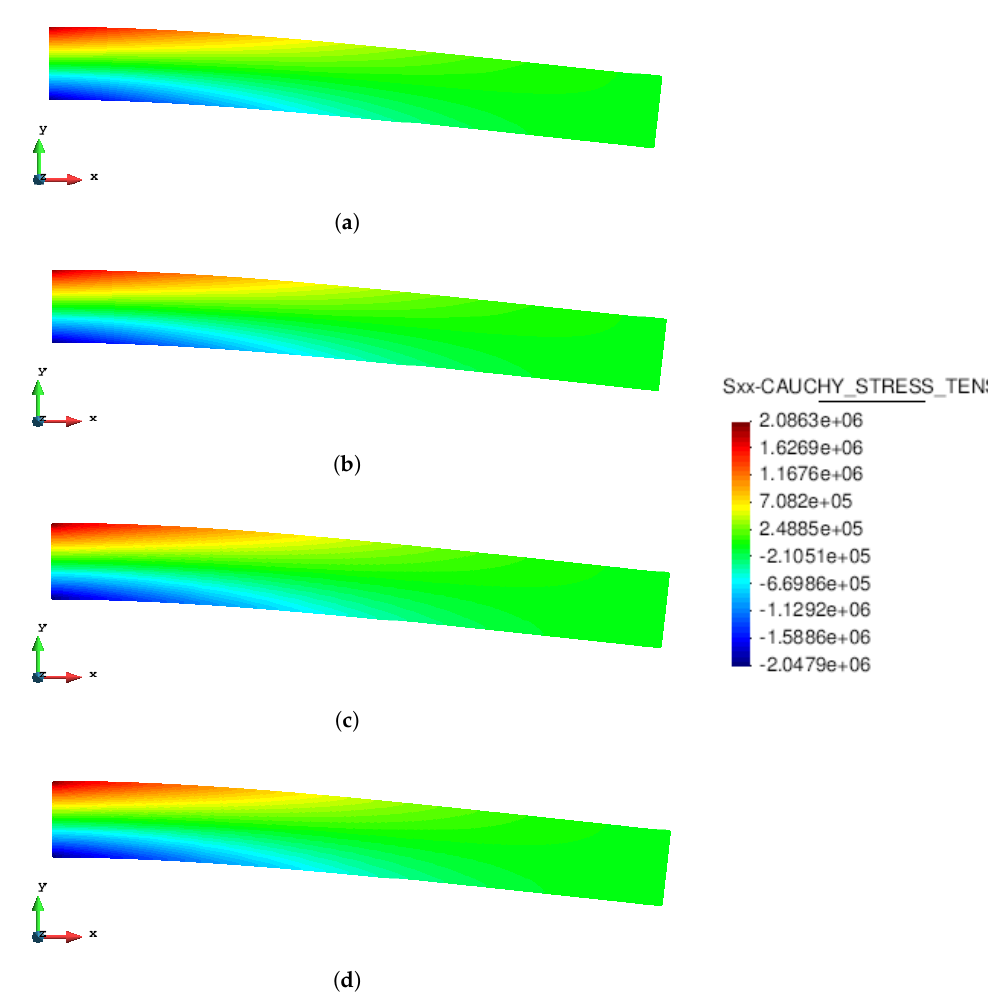
Figure 6. Static cantilever. Cauchy stress along the x-direction. ( a ) FEM code; ( b ) MPM code; ( c ) GMM-MLS code; ( d ) GMM-LME